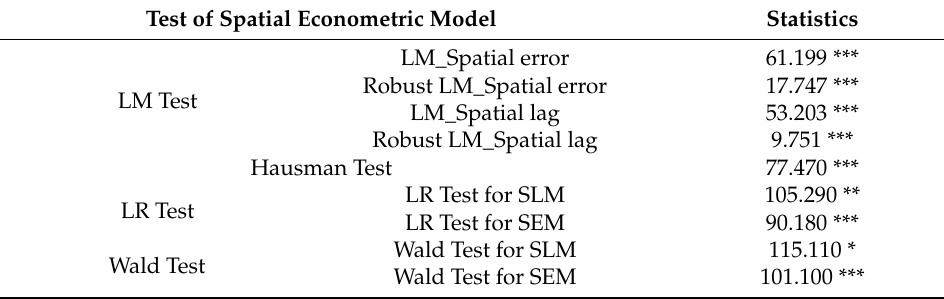
Figure 7. The flow chart of model selection. Table 8. Spatial econometric model test